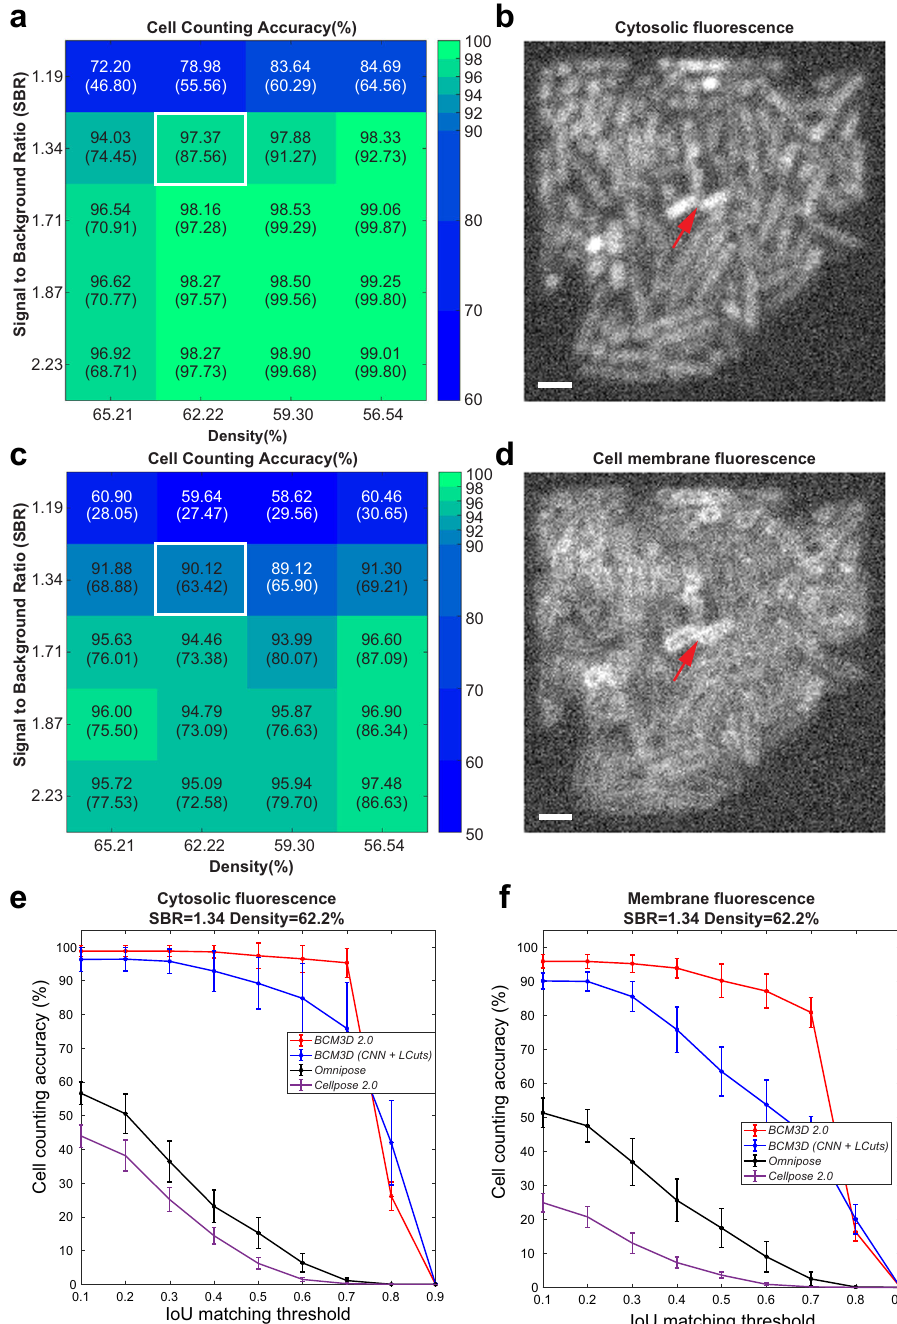
Fig. 1 Performance of BCM3D 2.0 on previously unseen simulated bio fi lm images. a Cell counting accuracy (using an Intersection-over- Union (IoU) matching threshold of 0.5 for each segmented object) averaged over N = 10 replicate datasets for cells labeled with cytosolic fl uorophores. IoU is a well-documented metric 23,30,60 quantifying the amount of overlap between predicted cell and actual cell volumes. b Example image of cells labeled with cytosolic fl uorophores (Cell density = 62.2%, SBR = 1.34, indicated by white rectangle in a . a Cell counting accuracy (using an IoU matching threshold of 0.5 for each segmented object) averaged over N = 10 replicate datasets for cells labeled with membrane-localized fl uorophores. d Example image of cells labeled with membrane-localized fl uorophores (Cell density = 62.2%, SBR = 1.34, indicated by white rectangles in c ). The red arrow indicates a close cell-to-cell contact. e , f Comparison of segmentation accuracies achieved by BCM3D 1.0 ( CNN + LCuts), Omnipose trained from scratch, Cellpose 2 fi ne-tuned and BCM3D 2.0 for cytosolic and membrane labeling, respectively (SBR = 1.34, cell density = 62.2%). Segmentation accuracy is parameterized in terms of cell counting accuracy ( y axis) and IoU matching threshold ( x axis). Each data point is the average of N = 10 independent bio fi lm images. Data are presented as mean values ± one standard deviation. Scale bars are 2